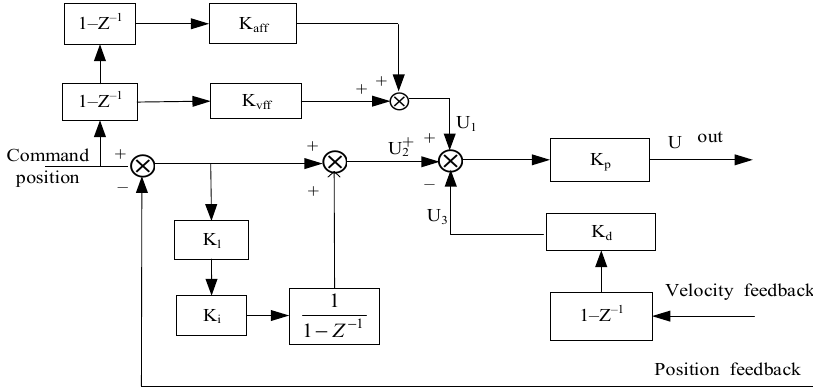
Figure 12. Position compound controller based on feed-forward proportional-integral-derivative (PID).